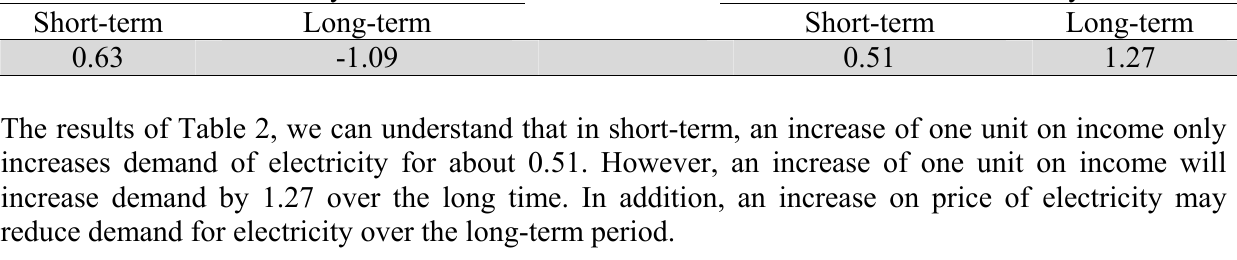
The effects of short-term and long term of price of electricity on demand for electricity Price